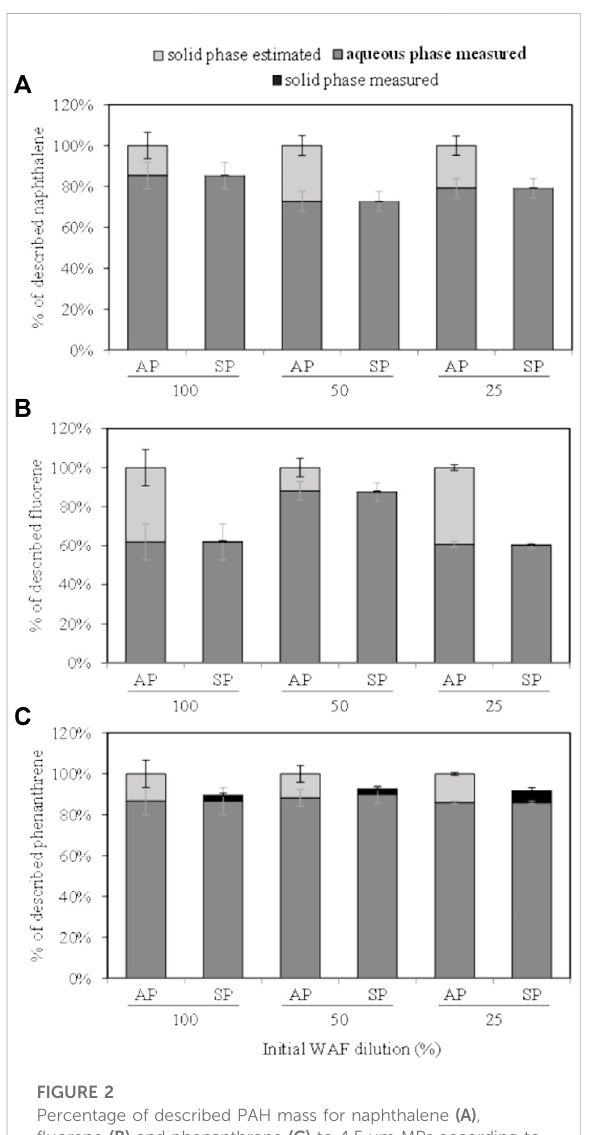
FIGURE 2 Percentage of described PAH mass for naphthalene (A) , fl uorene (B) and phenanthrene (C) to 4.5 μ m MPs according to measurements done in the aqueous phase (AP) or in aqueous and in solid phases (SP).